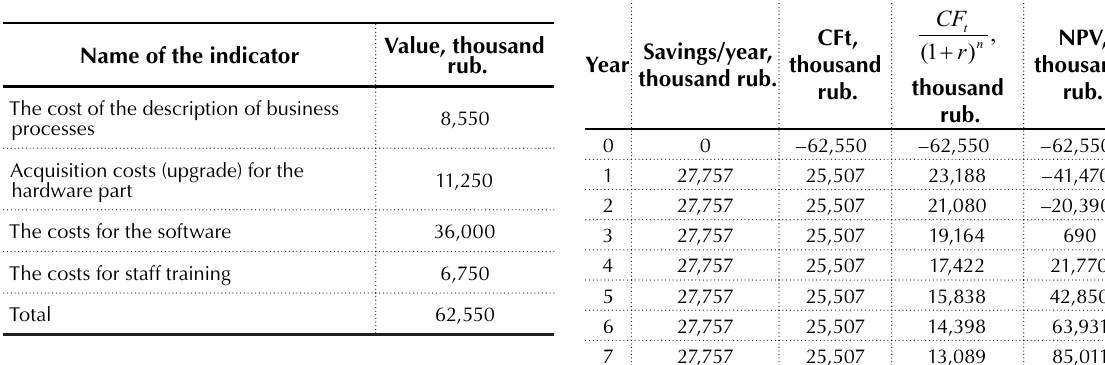
Table 2. Start-up costs for the project on implementation of a MES